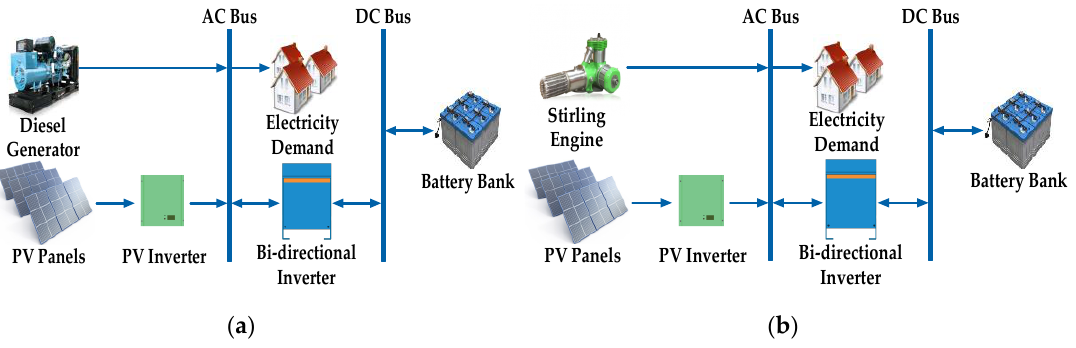
Figure 5. Overall configuration of the hybrid power systems. ( a ) Photovoltaic (PV)/diesel/battery; ( b ) PV/Stirling/battery.